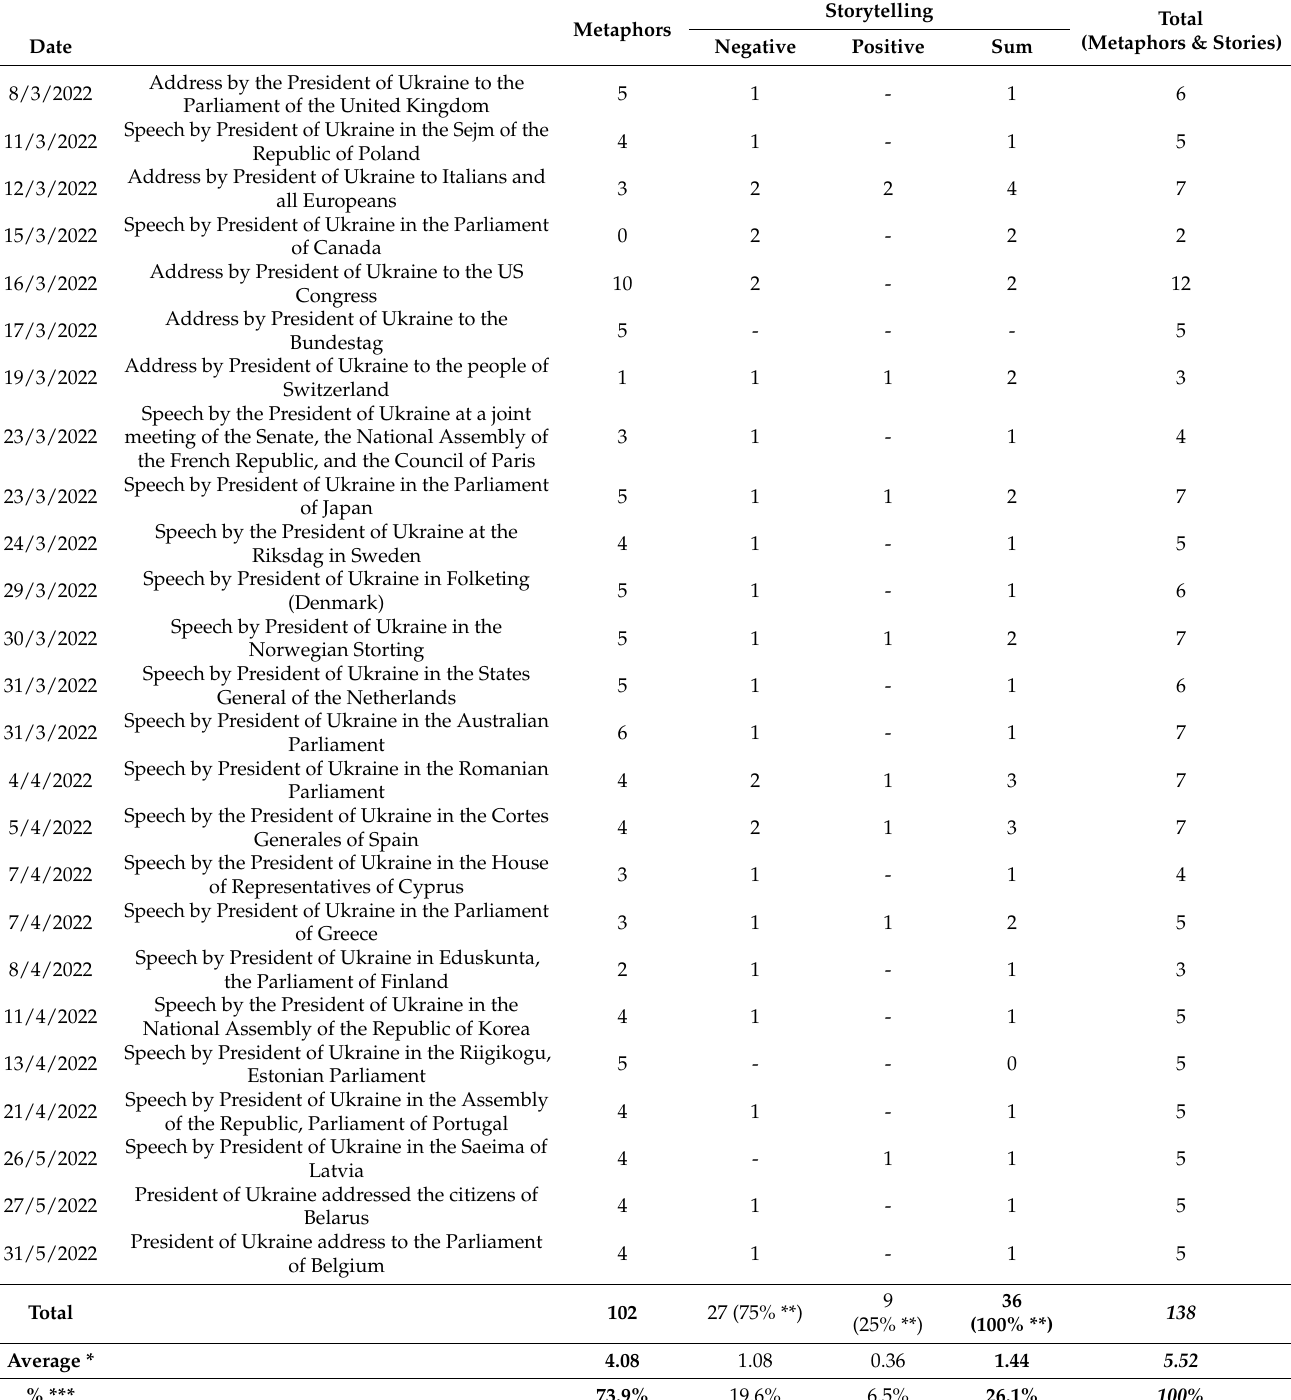
Table 6. Utilization of Different Types of Metaphors and Stories by the Ukraine President in Public